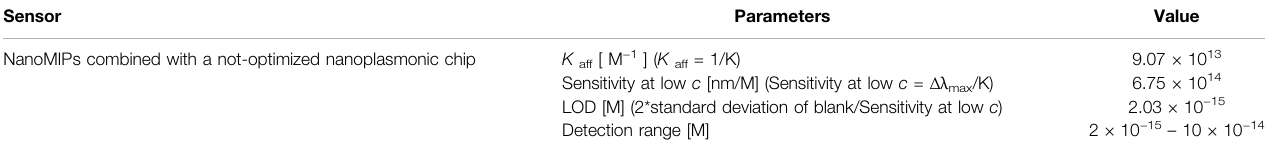
TABLE 2 | Sensor ’ s chemical parameters for BSA detection in buffer solution. Sensor